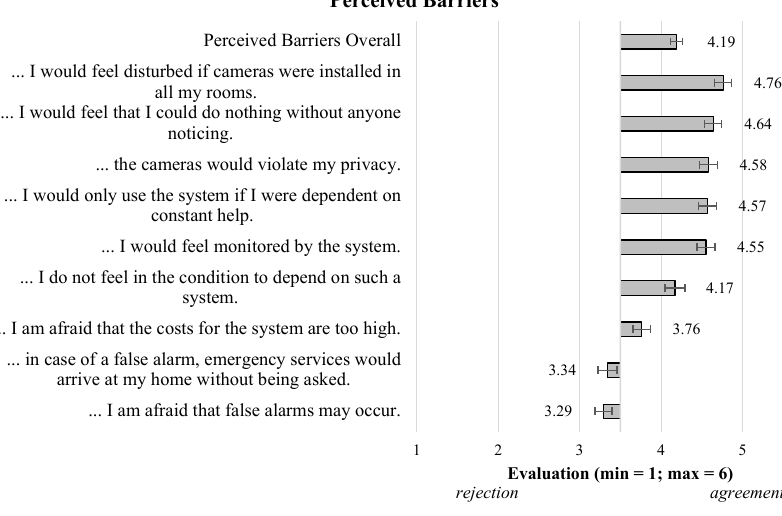
Figure 4. Perceived barriers to using video-based AAL technology (n =